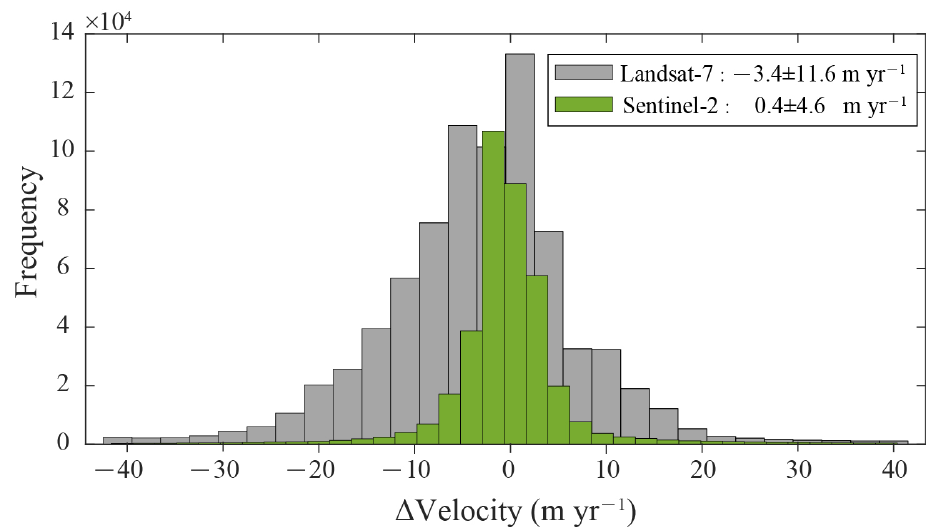
Figure 3. Velocity uncertainties. The Landsat-7 and Sentinel-2 derived velocities have a measurement error of − 3.4 ± 11.6 m yr − 1 and 0.4 ± 4.6 m yr − 1 ,